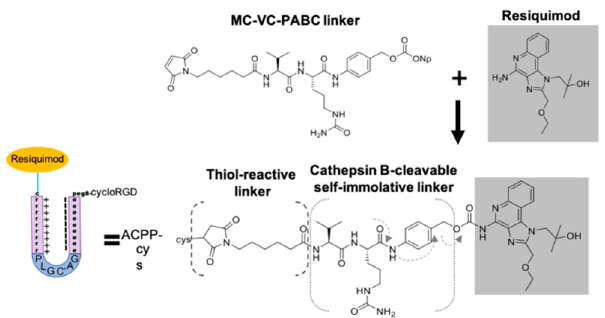
Figure 4. Conjugating resiquimod to ACPP. Chemical synthesis attaches resiquimod to a MC-VC- PABC linker.